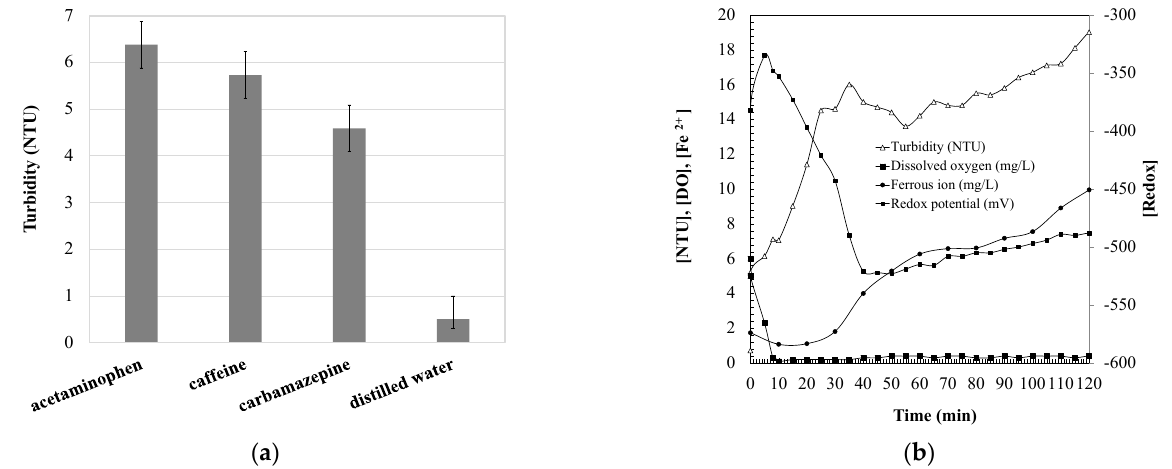
Figure 1. ( a ) Turbidity analyzed on aqueous solutions containing different PhACs oxidized by photo-Fenton. Experimental conditions: (C) = 50.0 mg/L; pH = 3.0; (H 2 O 2 ) = 15.0 mM; (Fe) = 10.0 mg/L; (UV) = 150 W; T = 25 °C. ( b ) Water quality indicators analyzed during the carbamazepine oxidation by photo-Fenton. Experimental conditions: (CBZ) = 50.0 mg/L; pH = 3.0; (H 2 O 2 ) = 2.0 mM; (Fe) = 10.0 mg/L; (UV) = 150 W; T = 25 °C.